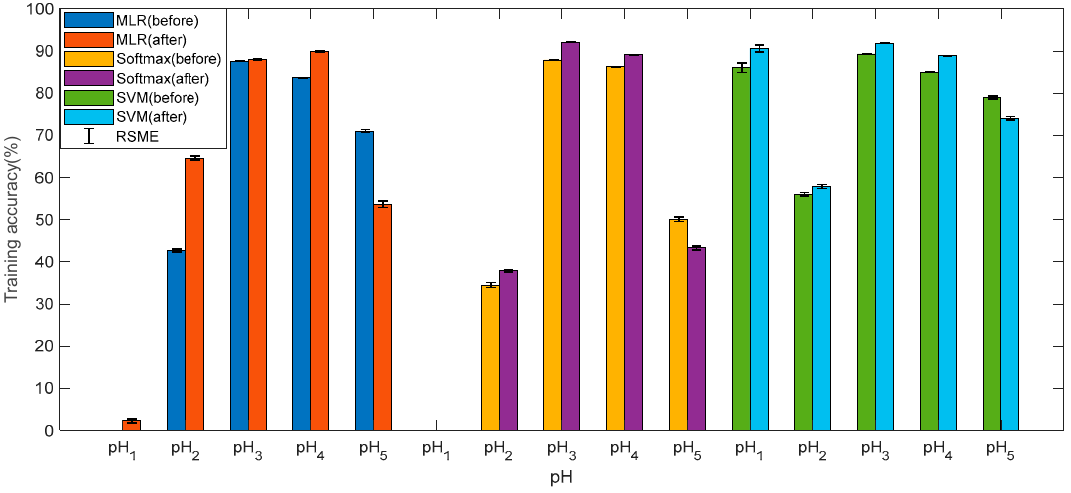
Figure 7. The training accuracy for each pH by three methods.